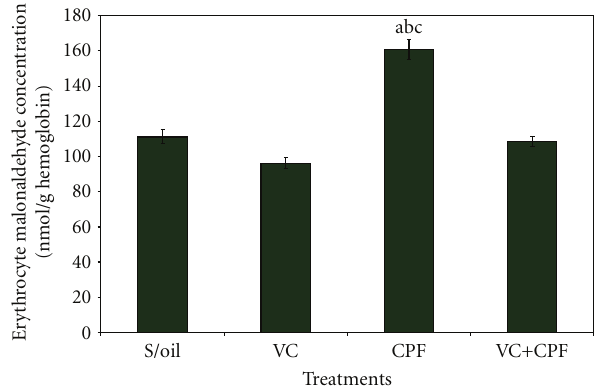
Figure 2: E ff ect of chronic exposure to soya oil (S/oil), vitamin C (VC), and/or chlorpyrifos (CPF) on erythrocytes malonaldehyde concentration. abc P < . 01 versus soya oil, vitamin C, and vitamin C+chlorpyrifos groups,